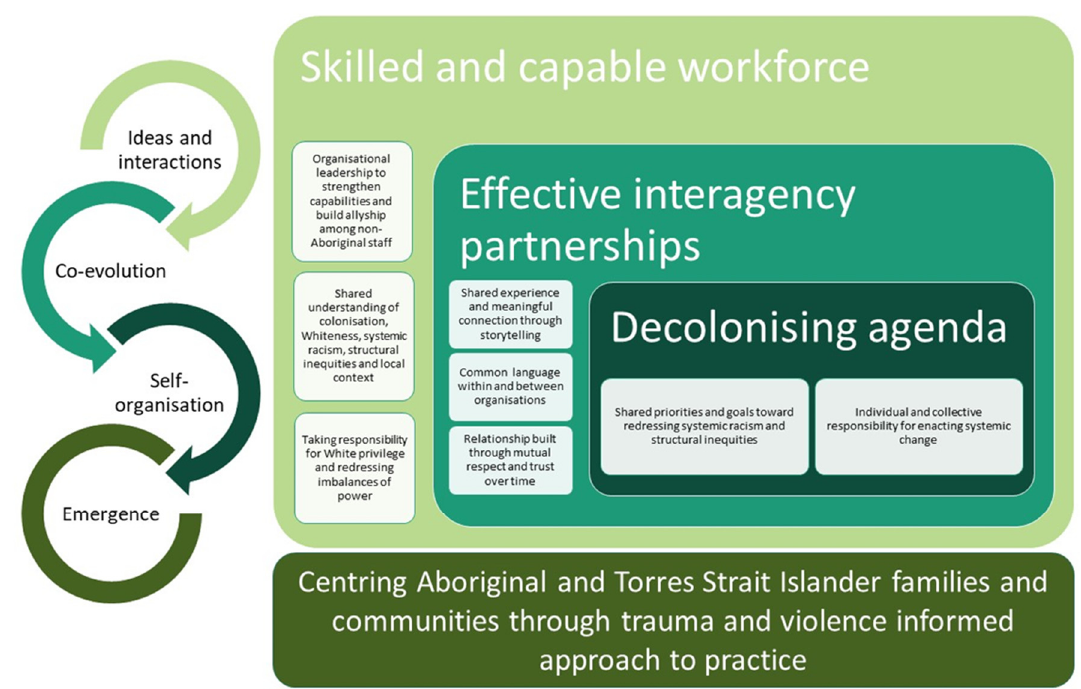
Figure 2. ACCHO-led model of systemic decolonisation that centers families and communities through: 1) enhancing the skills and capabilities of the workforce and 2) effective partnerships through meaningful connection, common language and relationships built through trust and respect over time to generate a shared decolonisation agenda. The circular arrows depict this process from a complexity perspective.